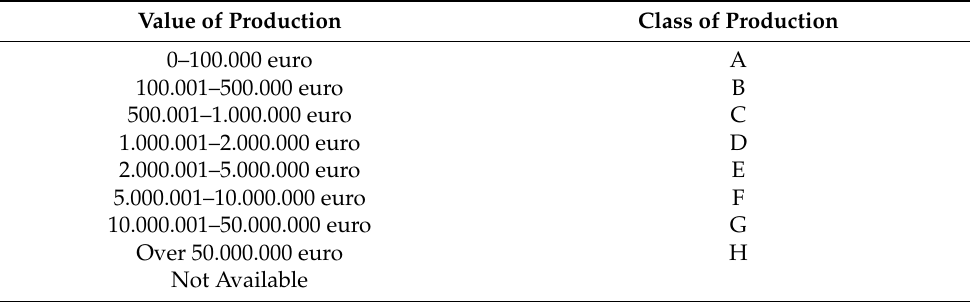
Table A2. Shows the startups classification to value of production cluster.